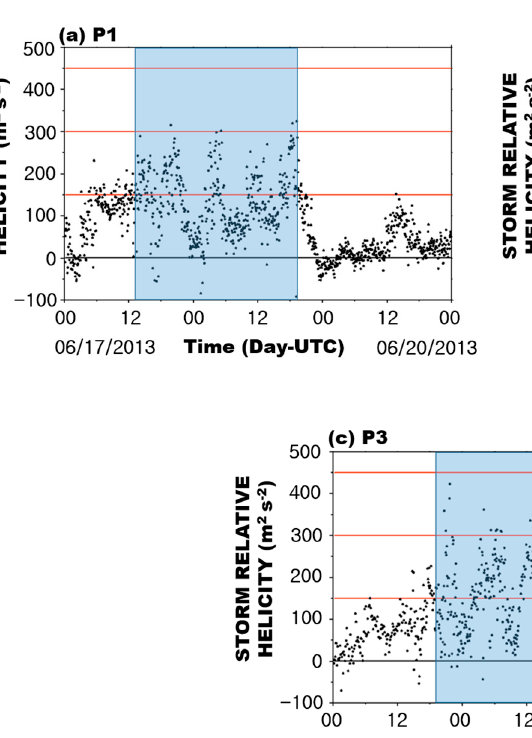
Figure 9. Storm relative helicity (SRH) produced from wind profiler observations ( a ) at P1, ( b ) at P0, and ( c ) at P3. The rainfall period is shaded in blue.